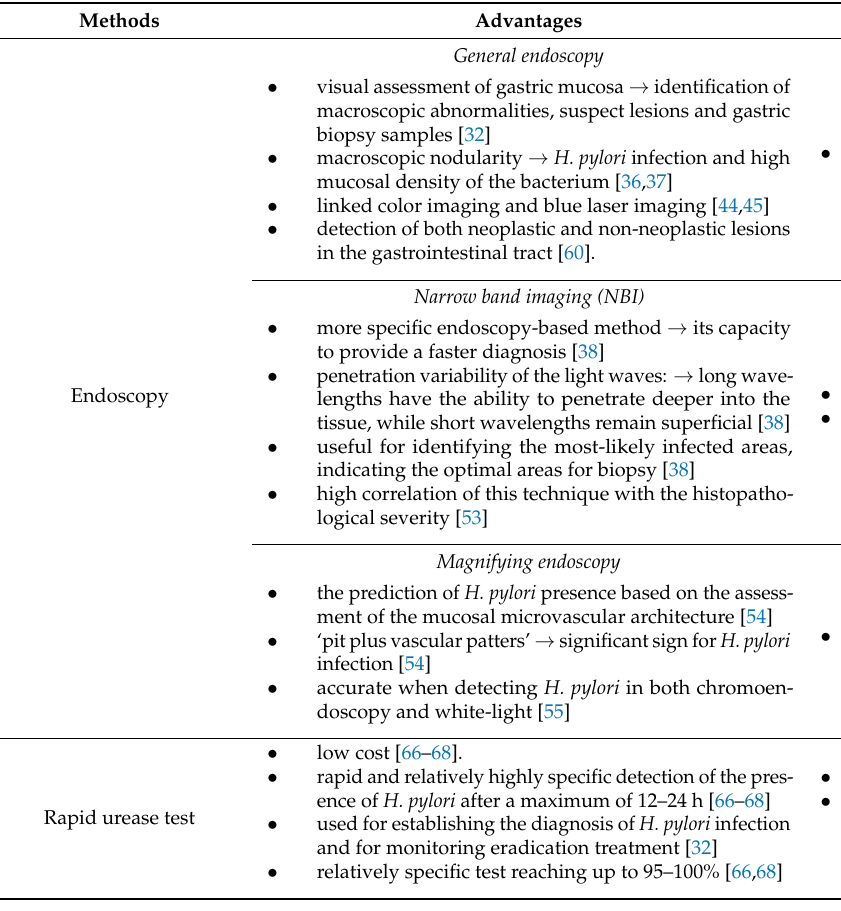
Table 1. Diagnostic tests for H. pylori